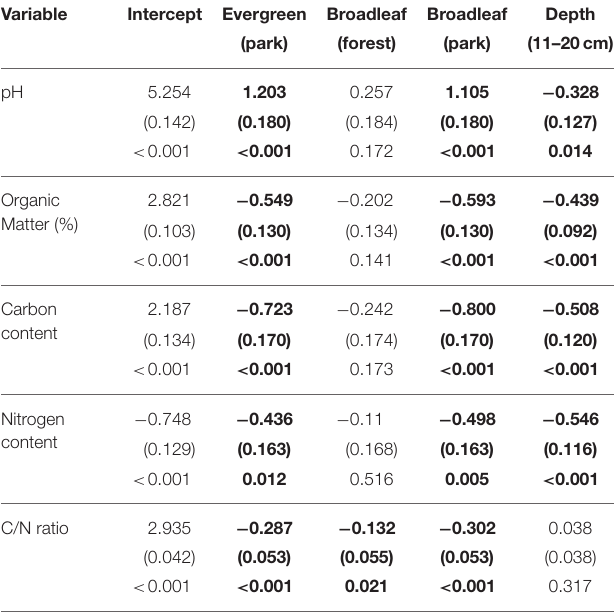
TABLE 2 | Linear model results, testing the effects of plant functional groups in natural forests and parks (a factor with four levels; natural evergreen forests, evergreen trees in old parks, natural deciduous forests, deciduous trees in old parks), sample depth (0–10cm, 11-20cm), and their